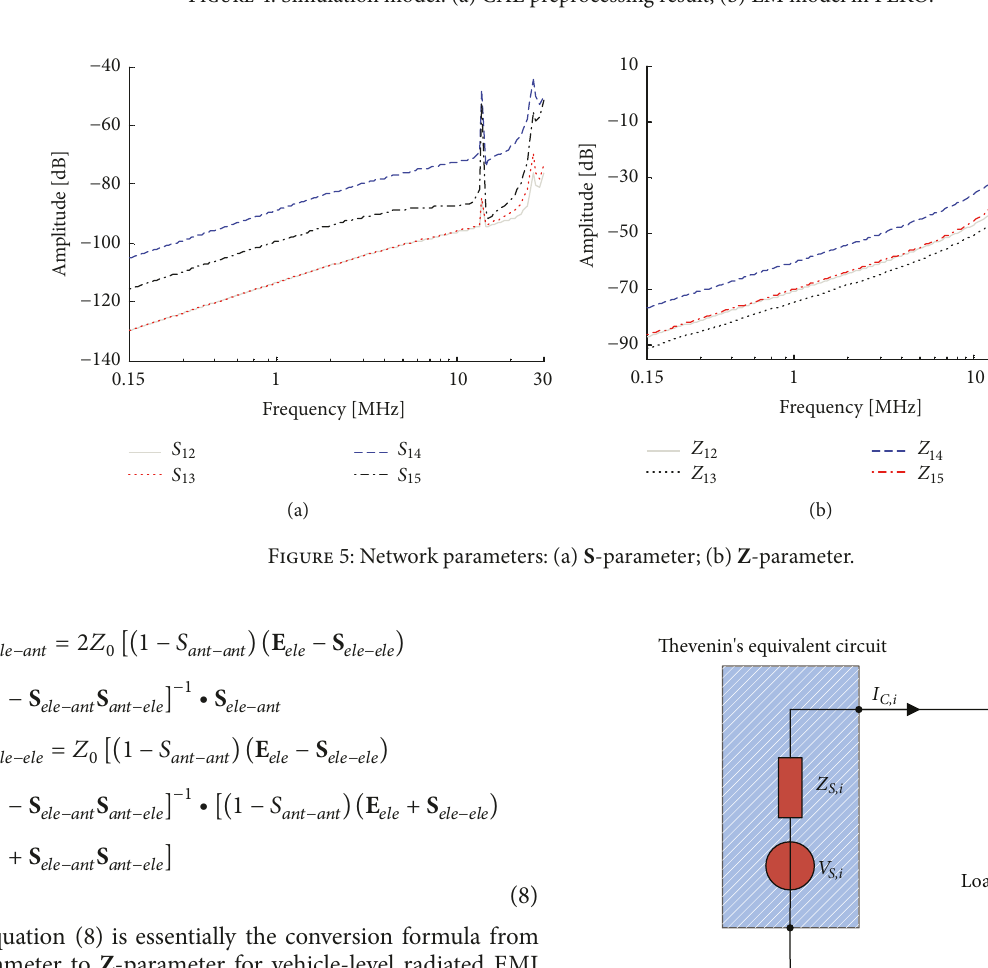
Figure 4: Simulation model: (a) CAE preprocessing result; (b) EM model in FEKO.